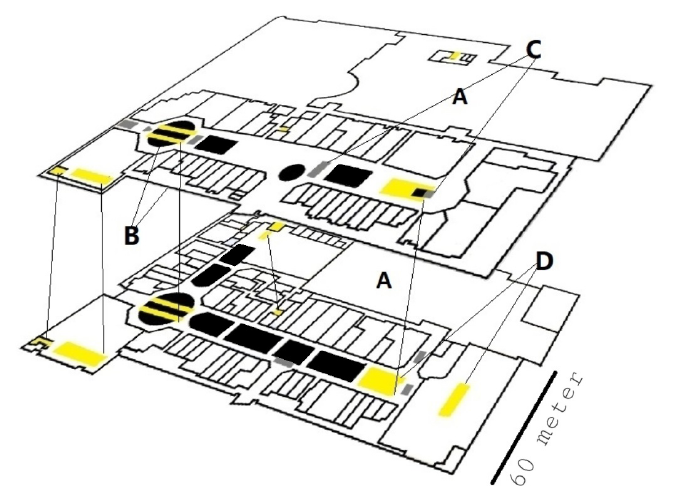
Figure 3. 2.5D multicolored map example used in the advanced algorithm. White (marked by the letter “ A ”) represents accessible areas; black (marked as “ B ”) represents restricted regions (in this case, walls); gray (“ C ”) represents dynamic inaccessible areas (tables, in this case); and yellow ( “ D ”) represents stairs and elevators, in which elevation change is